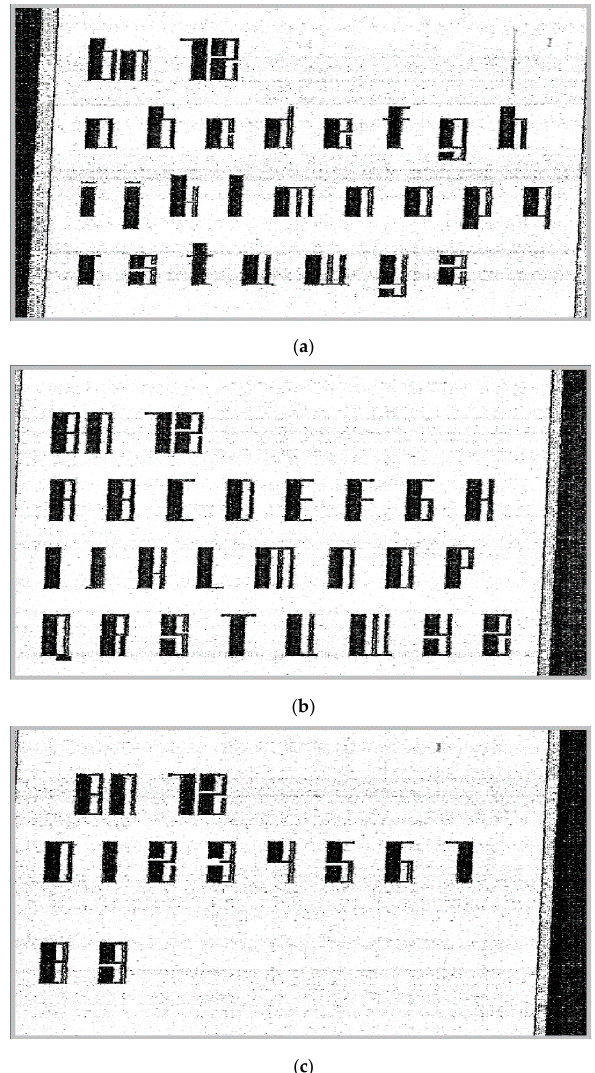
Figure 22. Secure asymmetrical font 72: ( a ) lower case letters with blank spaces, ( b ) upper case letters with blank spaces, ( c ) numbers with blank spaces.